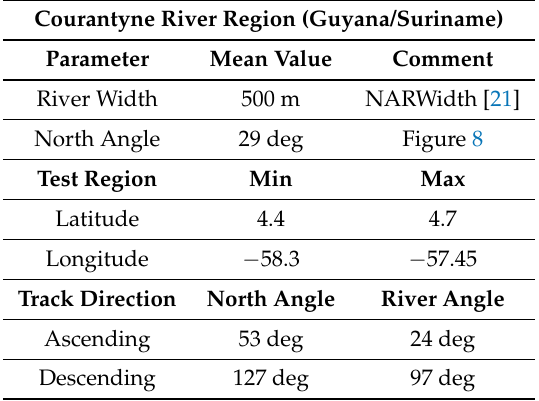
Table 3. Description of selected test region for river crossing coherency analysis.